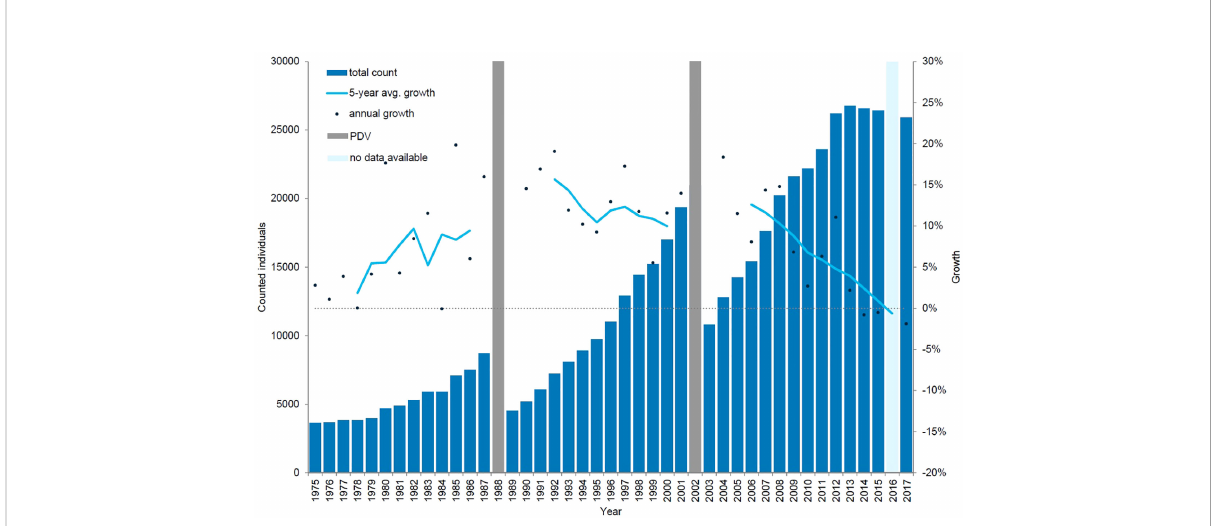
FIGURE 3 Harbor seal count in the Wadden Sea 1975 – 2017. No total number available for 1988, 2022, and 2016 due to Phocine Distemper Virus (PDV) or weather. Source: Jensen et al.,